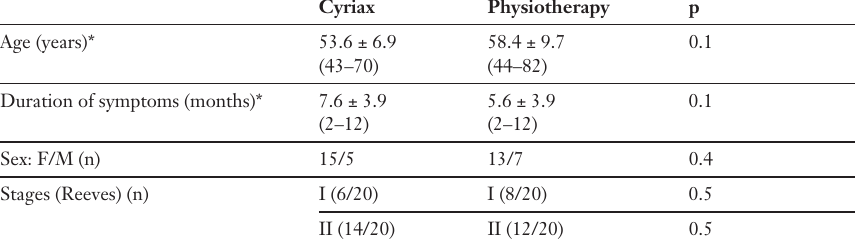
Demographics of the two groups of patients according to age, sex, duration of symptoms and the stages according to